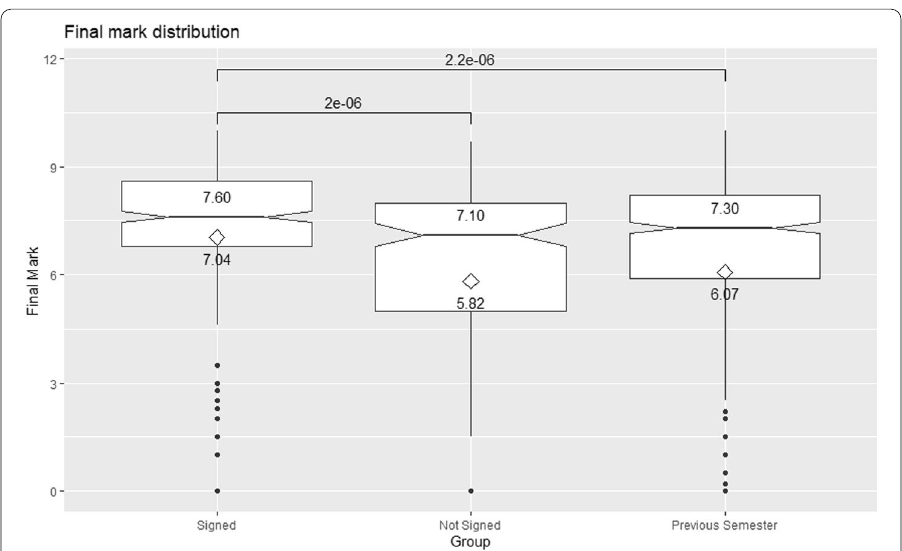
Fig. 6 Notched box‑and‑whisker plot of the final mark distribution with the corresponding p‑value of the unpaired two‑sample Wilcoxon test, median and mean (diamond sign) values for each group for Markets and behavior